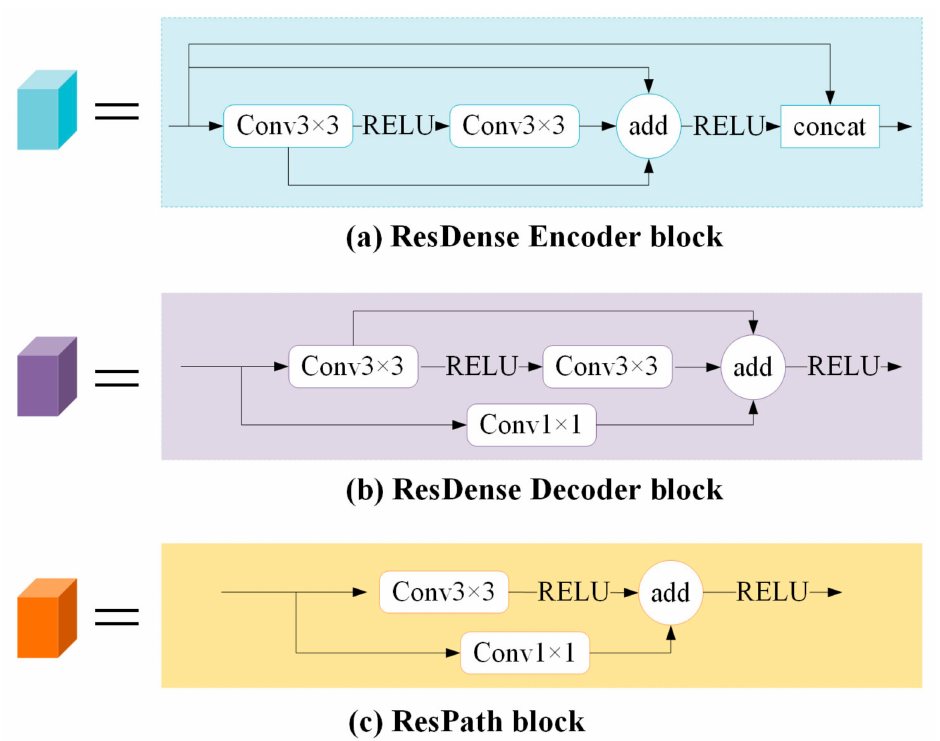
Figure 5. Details of several blocks: ( a ) residual dense encoder block; ( b ) residual dense decoder block; ( c ) residual path